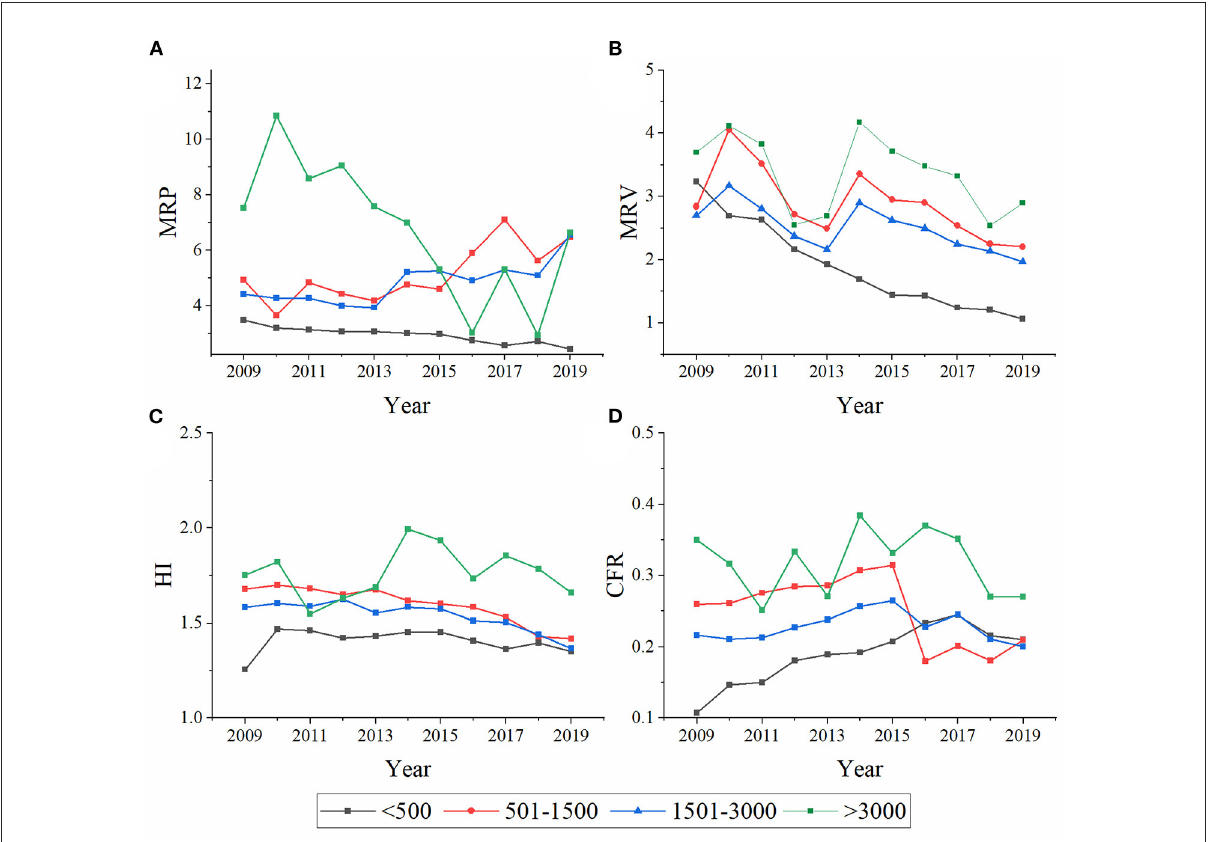
FIGURE4 Annual distribution of MRP (A) , MRV (B) , HI (C) , and CFR (D) at different altitudes.